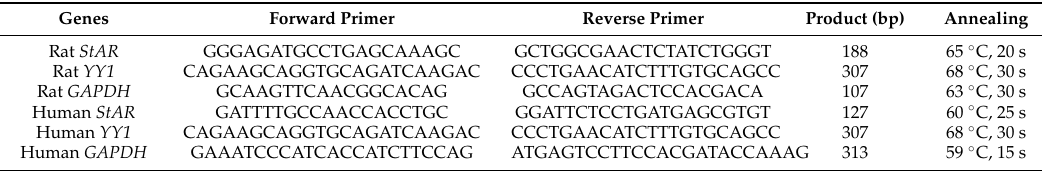
Table 1. Oligonucleotide primers and PCR conditions.